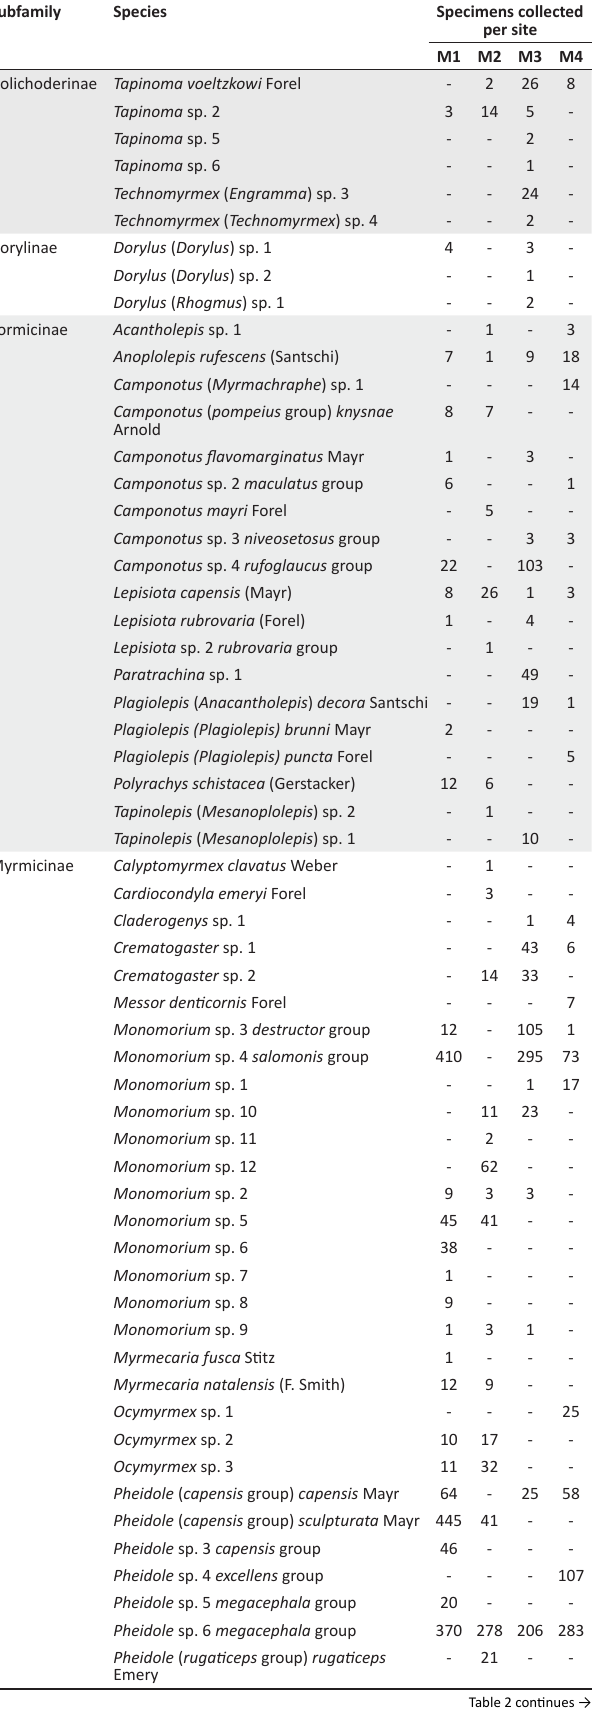
TABLE 2 (Continues...): Checklist of ants of the Marakele National Park, Limpopo province, South Africa. Subfamily Species Specimens collected per site M1 M2 M3 M4